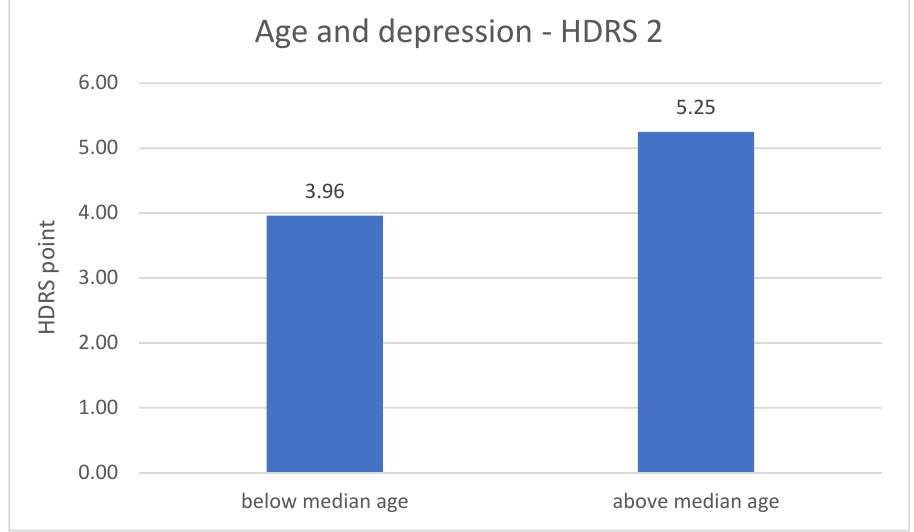
Figure 4. Age and the severity of depression—HDRS 2 measurement. The division of DD group in terms duration of the disease revealed significant differ- ence related to the severity of depression symptoms. The metric variable “disease dura- tion” was divided into two groups according to the median. The result of the HDRS test in the first measurement is higher in the group with a shorter disease duration ( p = 0.004). The results are described on Figure 5.